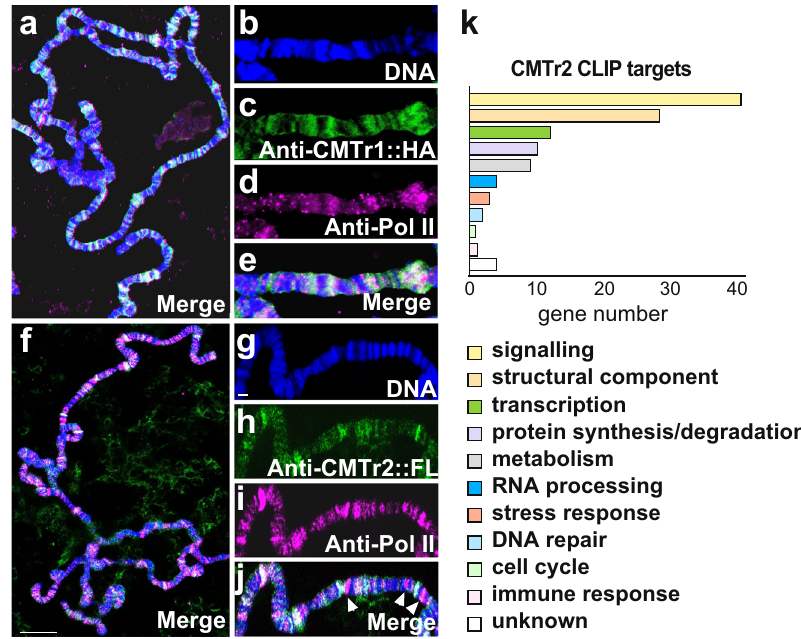
Fig. 4 CMTr2 localizes to distinct sites of transcription and has a dedicated set of targets. a – j Representative images of polytene chromosomes from salivary glands from three replicates expressing CMTr1::HA ( a – e ) or CMTr2::FLAG ( f – j ) stained with anti-Pol II (magenta, d , i ), anti-HA (green, c , h ), and DNA (DAPI, blue, b , g ), or merged (white, a , e , f , j ). Arrowheads indicate the absence of CMTr2. Scale bars in f are 10 µ m and in g are 2 µ m. k Functional classi fi cation of CMTr2 CLIP